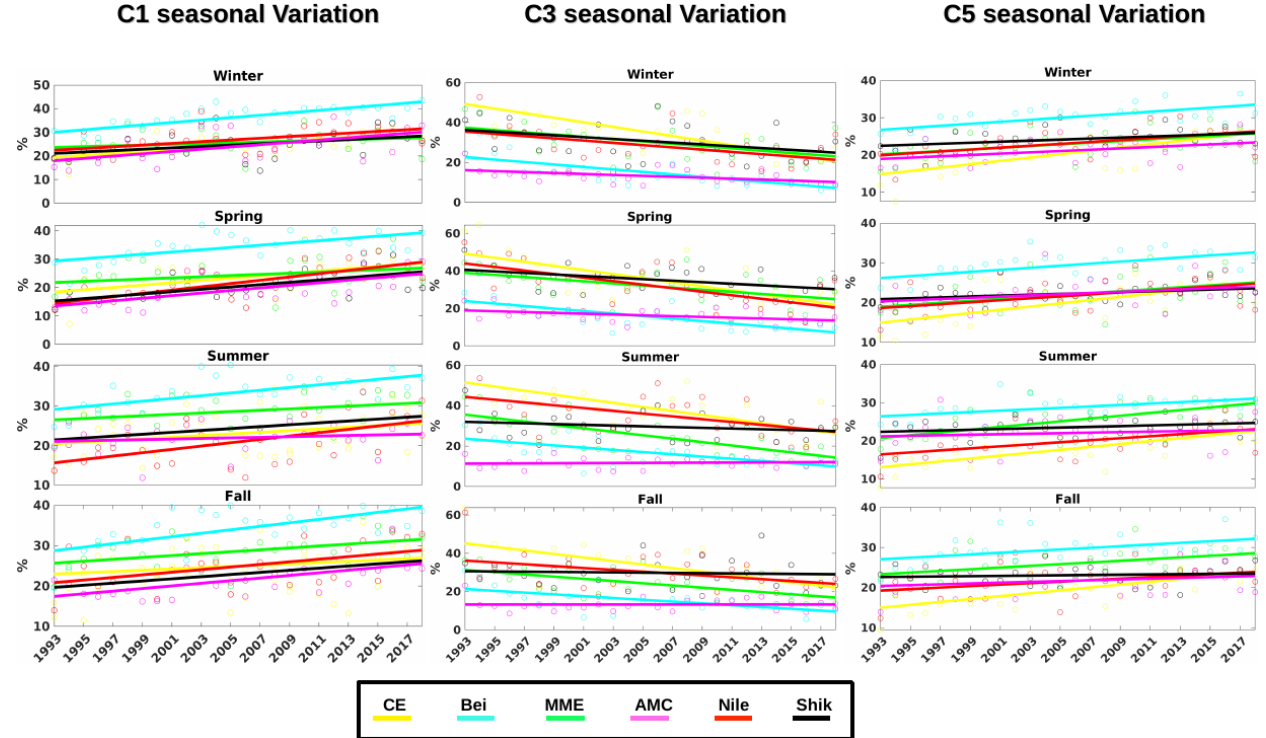
Figure 6. The seasonal variation of the C1 (high kinetic energy), C5 (high vorticity), and C3 (low kinetic energy and low vorticity) average in each box and their resulting linear